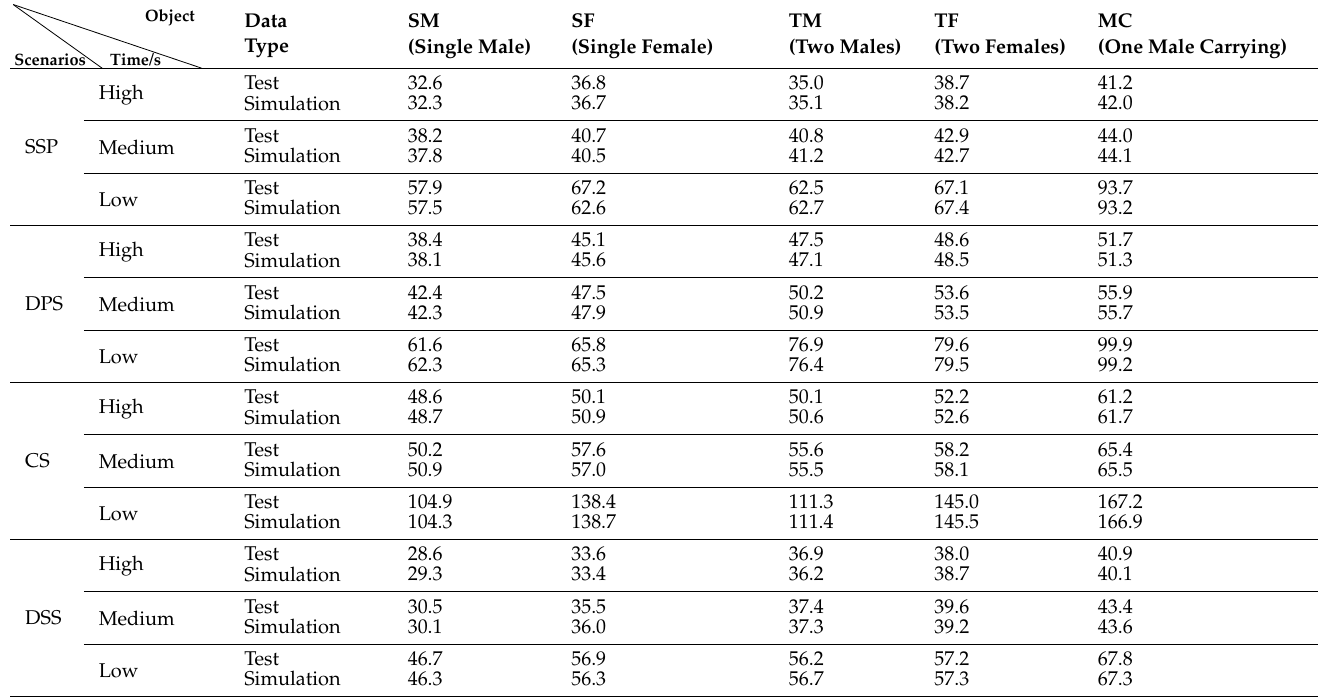
Table 3. Comparison of tested and simulated data.